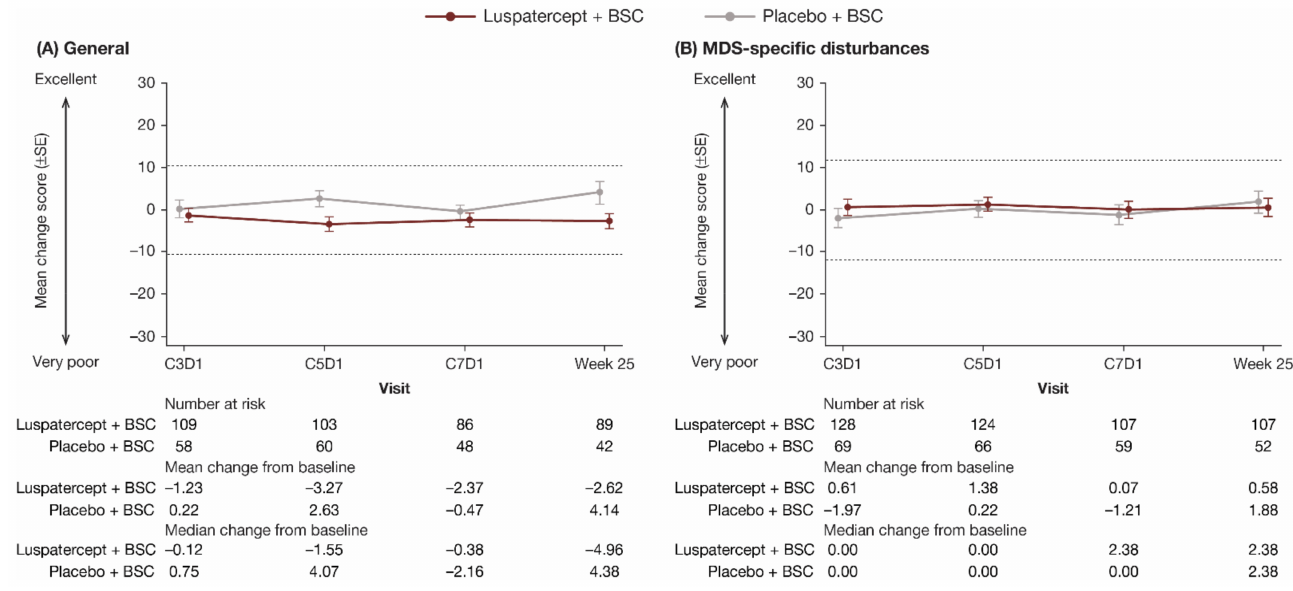
Figure 3. Observed mean change from baseline in patient-reported ( A ) General (summary of all domain scores except for MDS-specific disturbances) and ( B ) MDS-specific disturbances scores through week 25 on the QOL-E. Dashed lines indicate threshold for a clinically meaningful difference. BSC, best supportive care; C, cycle; D, day; MDS, myelodysplastic syndromes; QOL-E, Quality of Life Assessment in MDS questionnaire; SE, standard